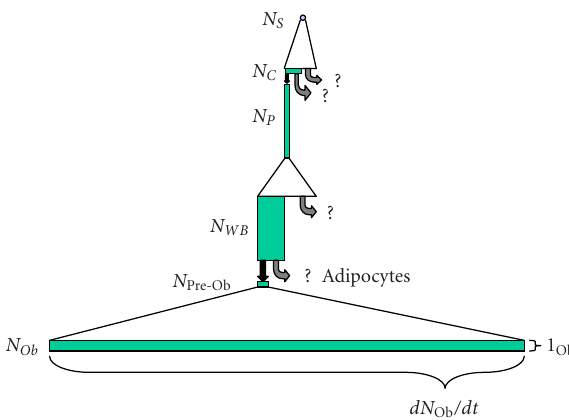
Figure 9. Transit cell populations upstream of osteoblasts. The putative transit cell populations that are upstream of the os- teoblast are shown, using the same illustration strategy described in Figures 6 and 7. The upstream originating stem cell, the peri- cyte, and the pre-osteoblast (type I osteoblast) are all presumed to be proliferating transit populations. Precise features of this diagram (the magnitude of expansion, the life-span, the rate of transit, and even pathways of transit between these potential populations) must be considered highly speculative, though it is consistent with available data and prevailing theory. Regardless of this speculation, it is useful to compare this diagram to that illustrating the events that occur downstream of the osteoblast shown in Figure 7. This comparison illustrates the very small rate of cell division and small rate of transit that must be ex- pected in transit populations upstream of the osteoblast, rela- tive to downstream events. Similarly, it also illustrates that one or more of these upstream populations (eg, the Westin-Bainton cell) might be present in comparable numbers to the active os- teoblast population, if the life-span of cells in these transit com- partments significantly greater that was the life-span of the se- cretory osteoblast. (Abbreviations: S, upstream stem cell; C, cir- culating stem cell; P, vascular pericytes; WB, Westen-Bainton Cells; Pre-Ob, Pre-osteoblast (Type I osteoblast); Ob, mature se- cretory